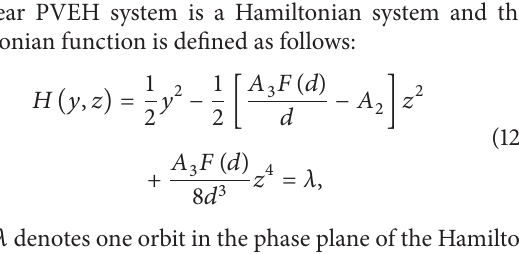
Figure 2: Potential function of the unperturbed nonlinear planar